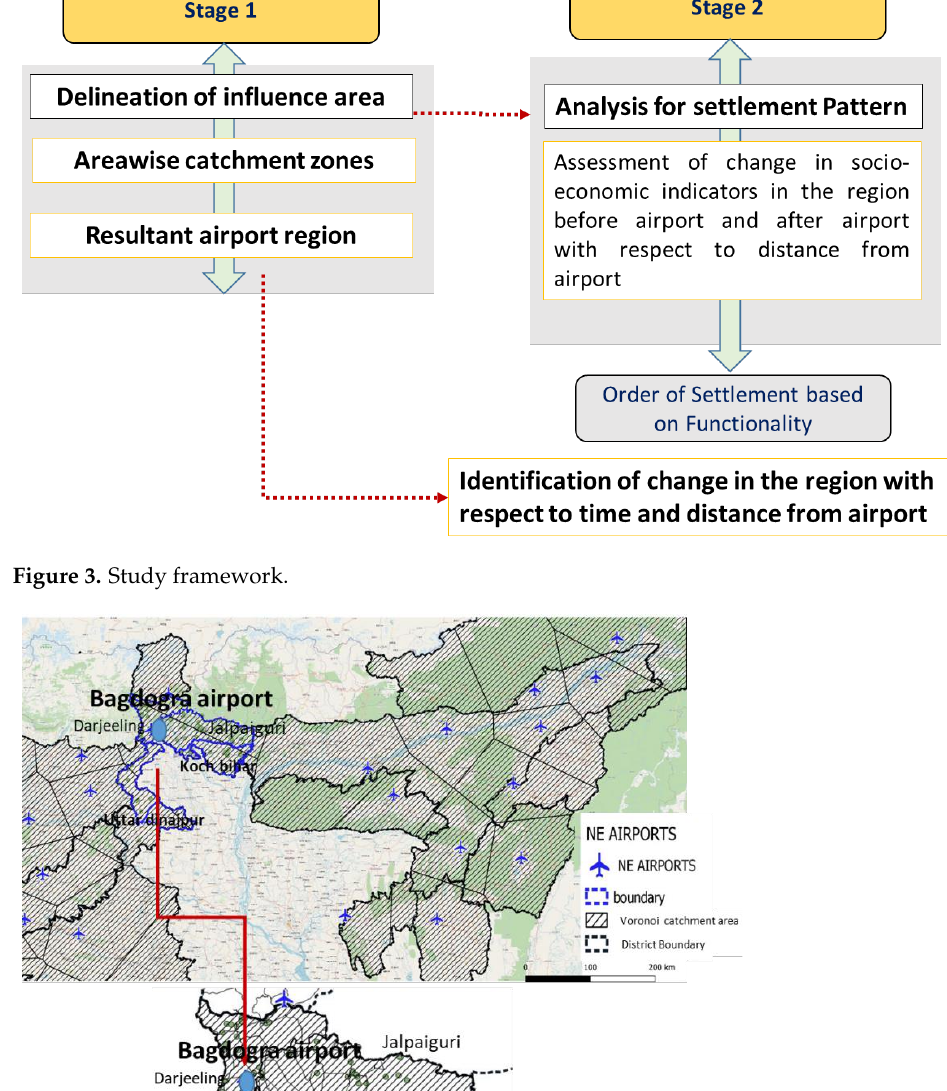
Figure 3. Study framework.